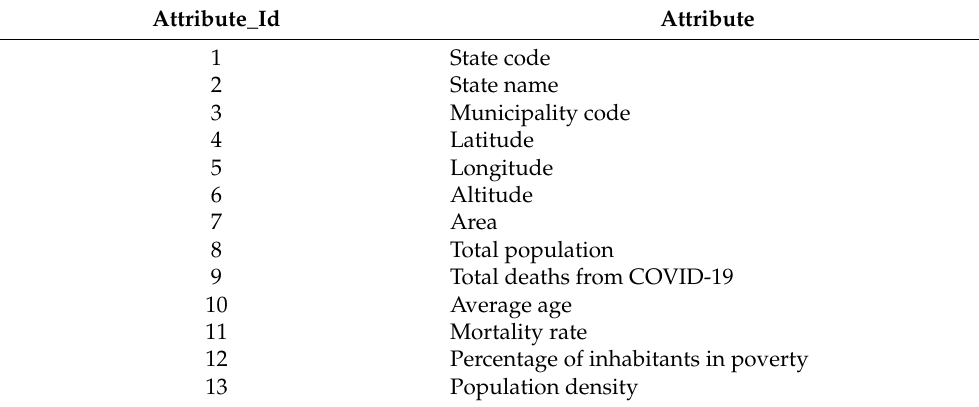
Table 3. Attributes of the data